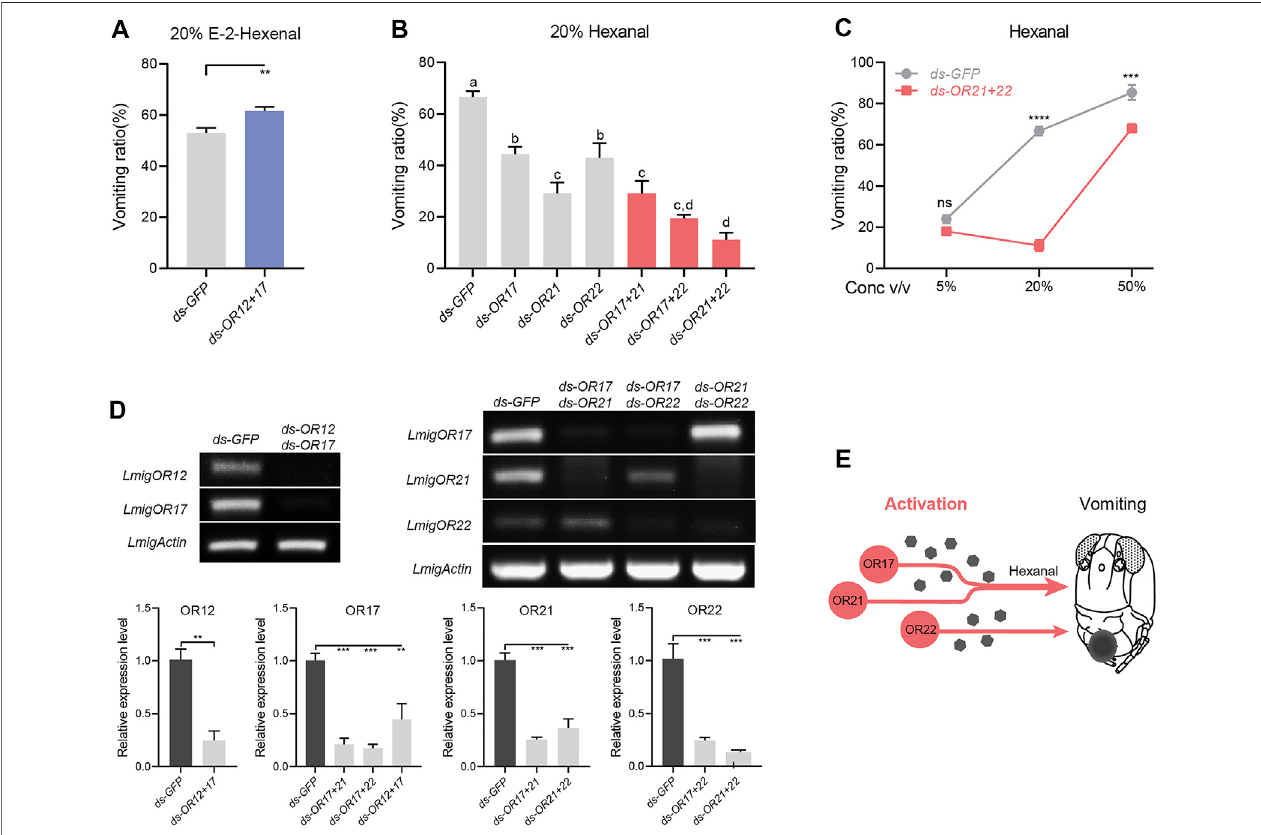
FIGURE 4 | Parallel and overlapping patterns between ORs in the control of vomiting. (A) Vomiting response assays toward 20% v/v E-2-hexenal with locusts treated with ds RNA mix of OR12 and OR17. n = 5 (24 locusts per replicate) for each assay. Statistical test: unpaired two-tailed t-test. (B) Vomiting response assays toward 20% v/v hexanal with locusts treated with individual dsRNA or a mix of two ORs. n = 3 – 5 (24 locusts per replicate) for each assay. Statistical test: ordinary one- wayANOVAwithuncorrectedFisher ’ sLSDtest. (C) Vomitingresponseassaystowardhexanalatconcentrationsof5 – 50%v/vwithlocuststreatedwithdsRNAmix of OR21 and OR22. n = 3 (24 locusts per replicate) for each assay. Statistical test: two-way ANOVA with uncorrected Fisher ’ s LSD test. (D) Effects of RNAi against two ORs, n =3.Statisticaltest:unpairedtwo-tailedt-testandordinaryone-wayANOVAwithuncorrectedFisher ’ sLSDtest. (E) SchematicmodelshowingthatOR17,OR21, and OR22 function in both overlapping and parallel manners. For all analyses, statistical differences are represented as follows: ns, not signi fi cant, ** p < 0.01, *** p < 0.001, and **** p < 0.0001. Different letters indicate statistically signi fi cant differences between groups. Data are represented as the mean ± SEM.